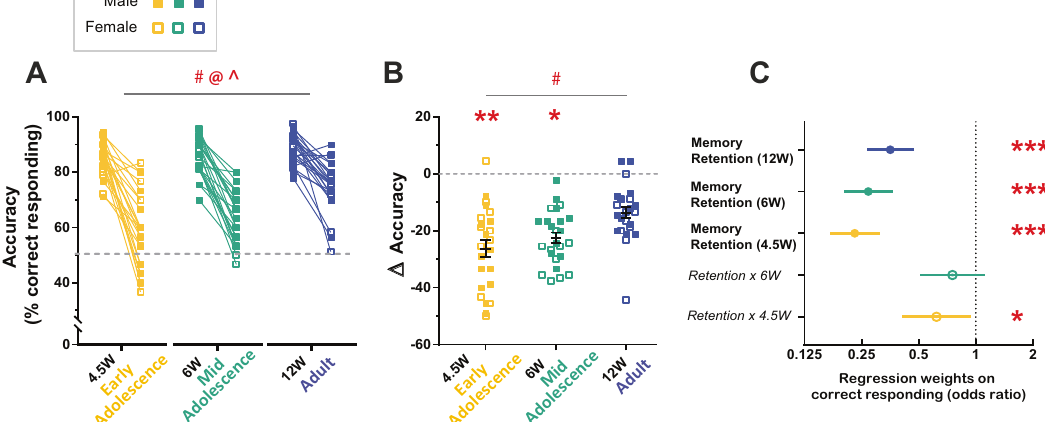
Fig. 5 Visuospatial memory retention on the rodent touchscreen two-object sPAL test. Following sPAL training (sessions 1 – 19) by when mice were performing at 85 – 90% accuracy (Fig. 3B, C), mice were rested for 2 weeks then memory retention assessed (session 20). A Accuracy (% correct responding) on sessions 17 – 19 compared to session 20 showed signi fi cant effects of age ( F (2,67) = 13.84, P < 0.001), rest period on memory retention (i.e. performance at session 17 – 19 vs. session 20) ( F (1,67) = 243.15, P < 0.001) and an age × rest period interaction ( F (2,67)